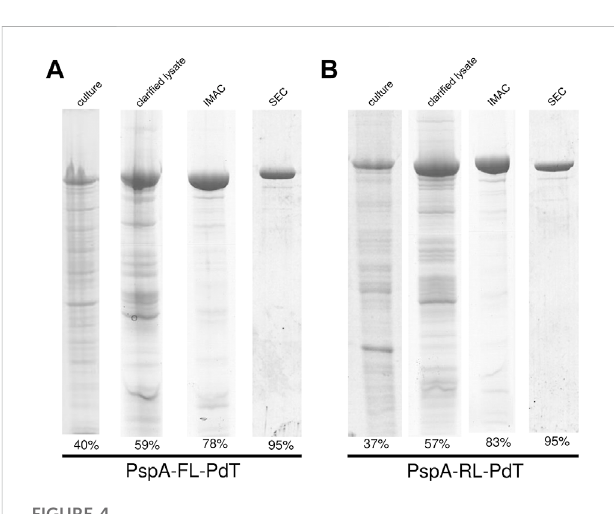
SDS-PAGE and gel densitometry for analysis of each puri fi cation step of the fusion proteins. (A) rPspA-FL-PdT puri fi cation steps: total protein from induced culture (40% purity), soluble fraction of clari fi ed lysate (59%), elution of IMAC (78%) and elution of SEC (95%). (B) rPspA-RL-PdTpuri fi cationsteps:totalproteinfrominducedculture(37% purity), soluble fraction of clari fi ed lysate (57%), elution of IMAC (83%) and elution of SEC